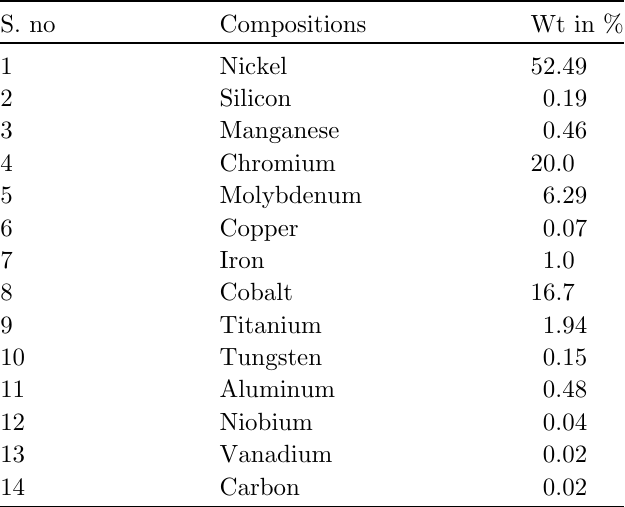
Table 1. Chemical composition of Nimonic C263